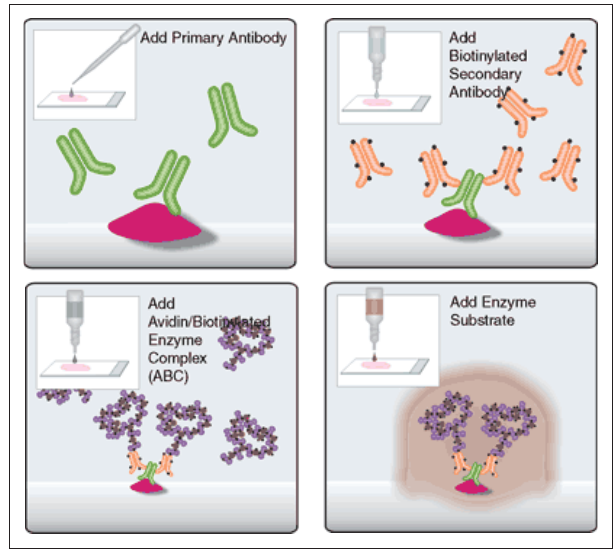
FIGURE 2: ABC Vector Elite immunoperoxidase staining